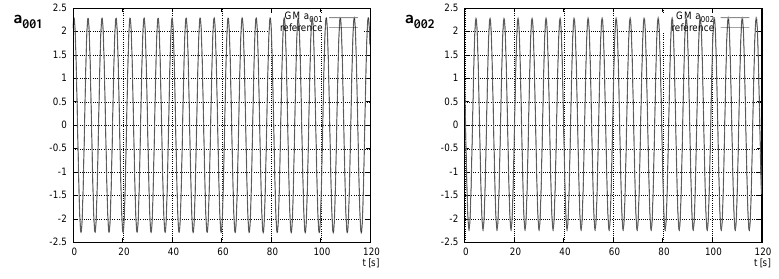
Figure 12. Two-equation Galerkin model with l + ij and q + ijk terms calibrated.